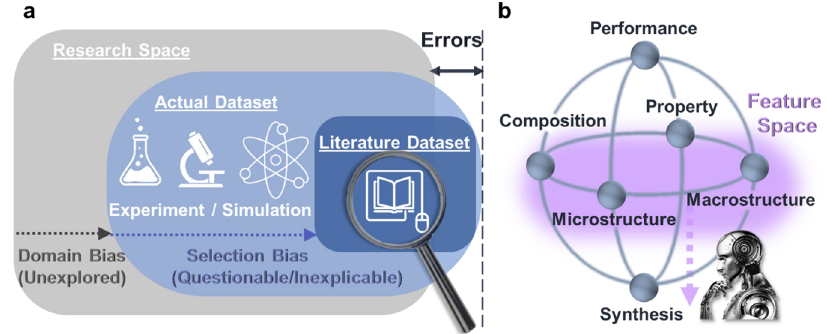
Fig. 1 Impact of datasets and feature sets in implementing ML for materials research. a Materials literature with a heterogeneous dataset due to domain bias and selection bias. Domain bias results when training datasets do not adequately cover the research space. Selection bias arises when some external factors such as questionability and inexplicability restrict the likelihood of a data inclusion in the datasets; such data can be either experimental, theoretical, or computational. b Holistic description of the synthesis, composition, microstructure, and macrostructure of materials, which are related to material properties and performance. Identifying a suf fi cient feature space with essential variables such as synthesis parameters requires careful observation and lateral